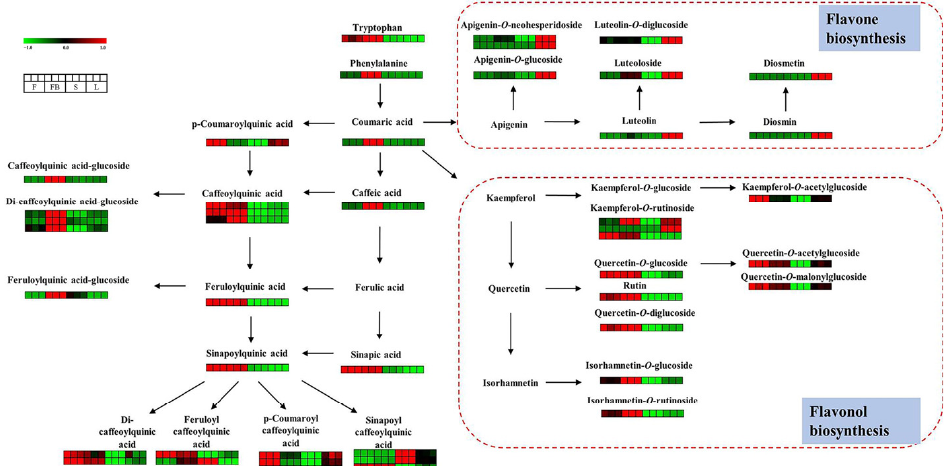
Figure 5. Visualization of phenolic acids and flavonoids in biosynthesis pathway map. Red box represents a higher content, and green box represents a lower content.